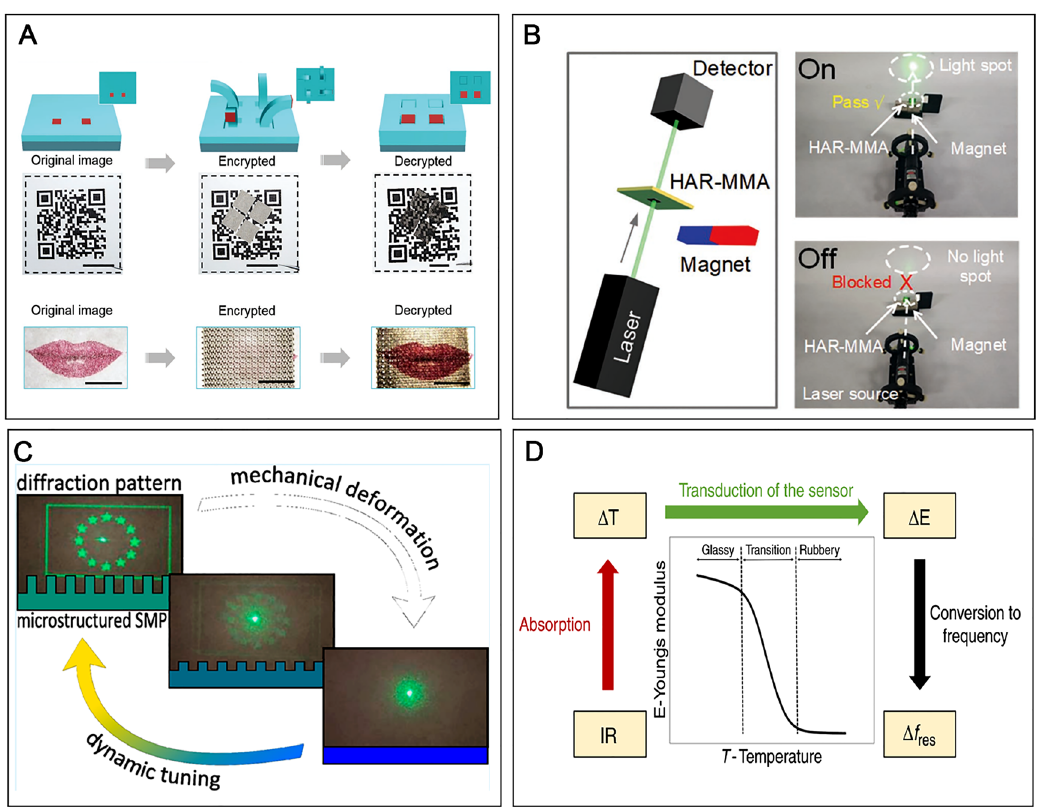
Figure 6: Metasurfaces based on SMPs tuned by shape memory effects. (A) Encryption and decryption conversion process of the images realized by femtosecond laser scanning on a prestretched SMP surface [181]. (B) An optical shutter switched by modulating the bending state of HAR-MMA [184]. (C) The conversion process of the diffractive optical element made of thermal response type SMP and the reversible change of its diffraction pattern [190]. (D) The working principle of the IR SMP sensor